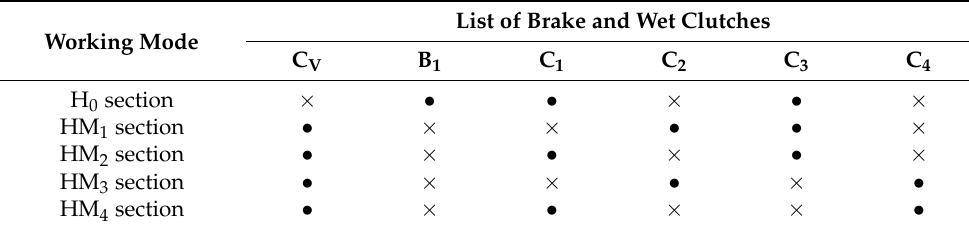
Table 1. Working modes